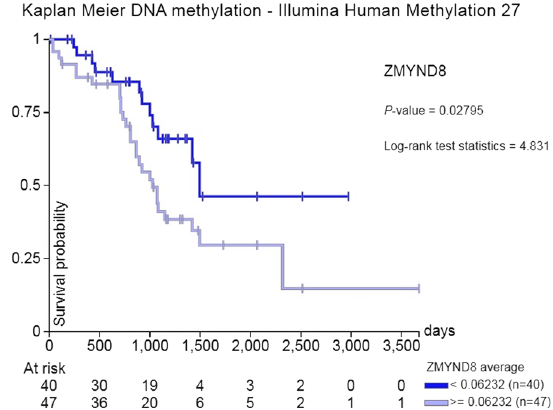
Fig. 4 Kaplan–Meier survival analysis for ZMYND-8. The data unexpectedly indicated that ZMYND-8 hypomethylation is significantly associated with the higher survival ratio of NSCLC